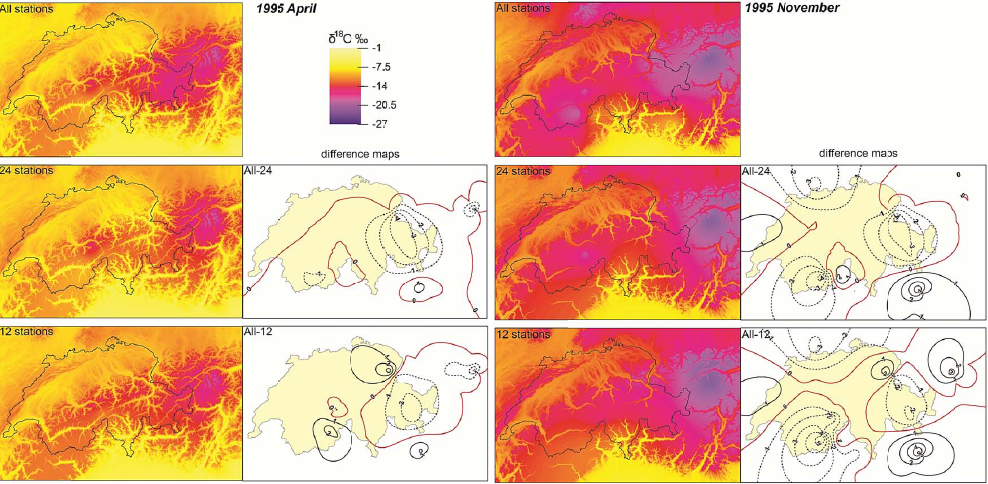
Fig. 5. Precipitation oxygen isoscapes for Switzerland derived for April 1995 and November 1995. For further explanation see the caption of Fig.